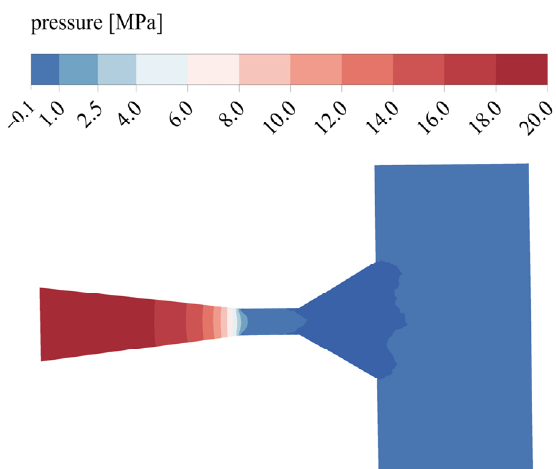
Figure 12. Pressure distribution of the angular cavitation nozzle.